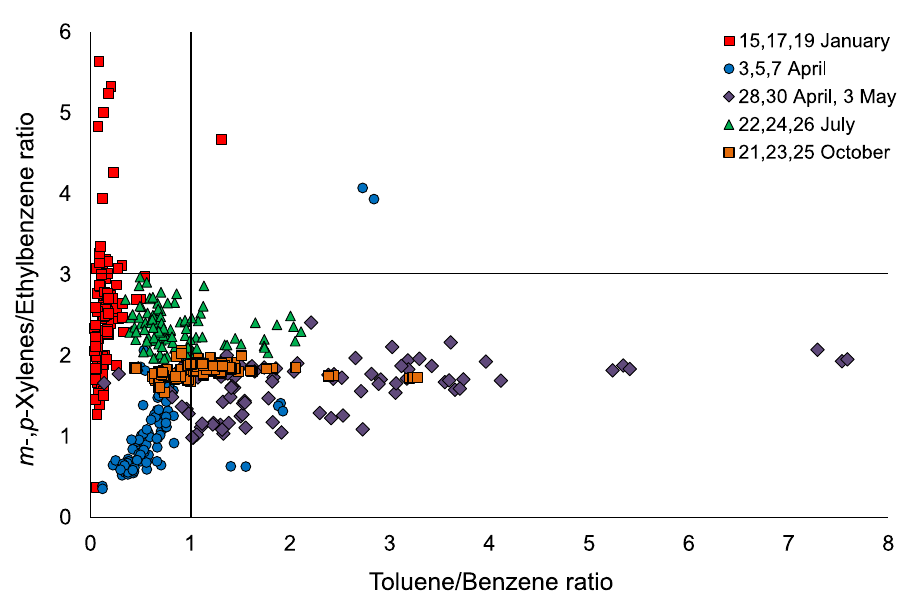
Figure 5. The ratios of BTEX at different sampling periods.